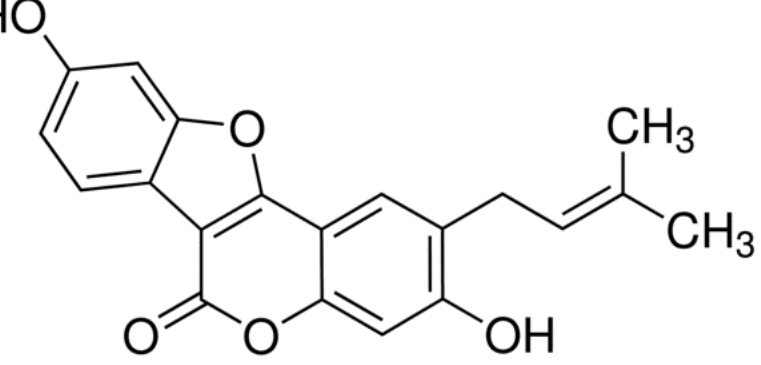
Figure 1. Chemical structure of psoralidin.